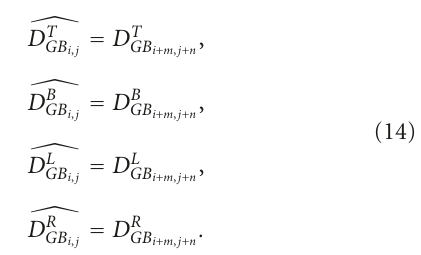
From (12), the directional D GB values are temporary defined as